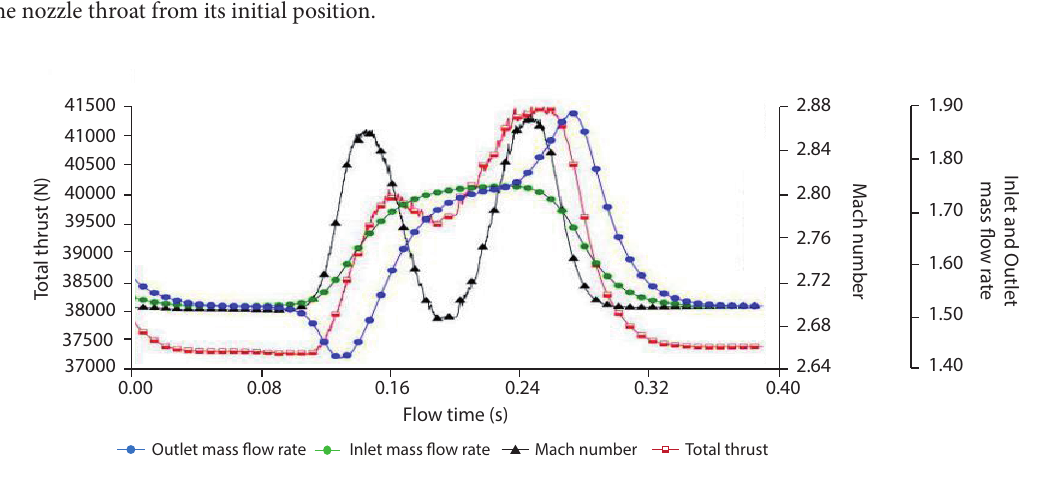
Figure 12. Simulation data of parabolic pintle head Mach number, mass flow rate and total